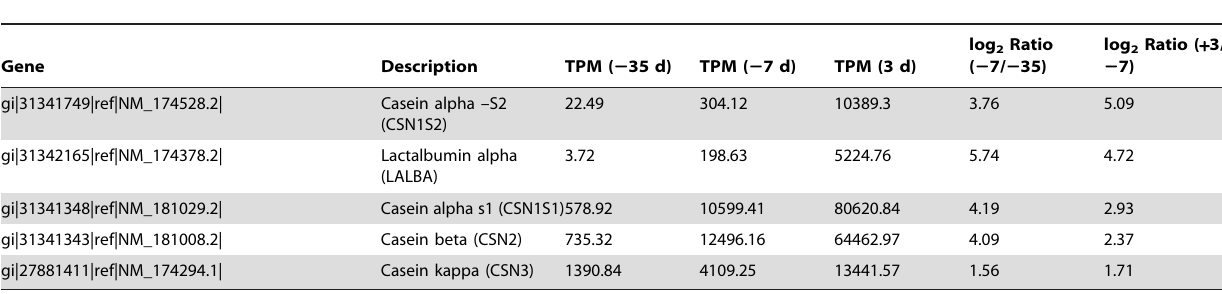
Table 5. Expression changes of milk protein genes during the two stages of lactogenesis.